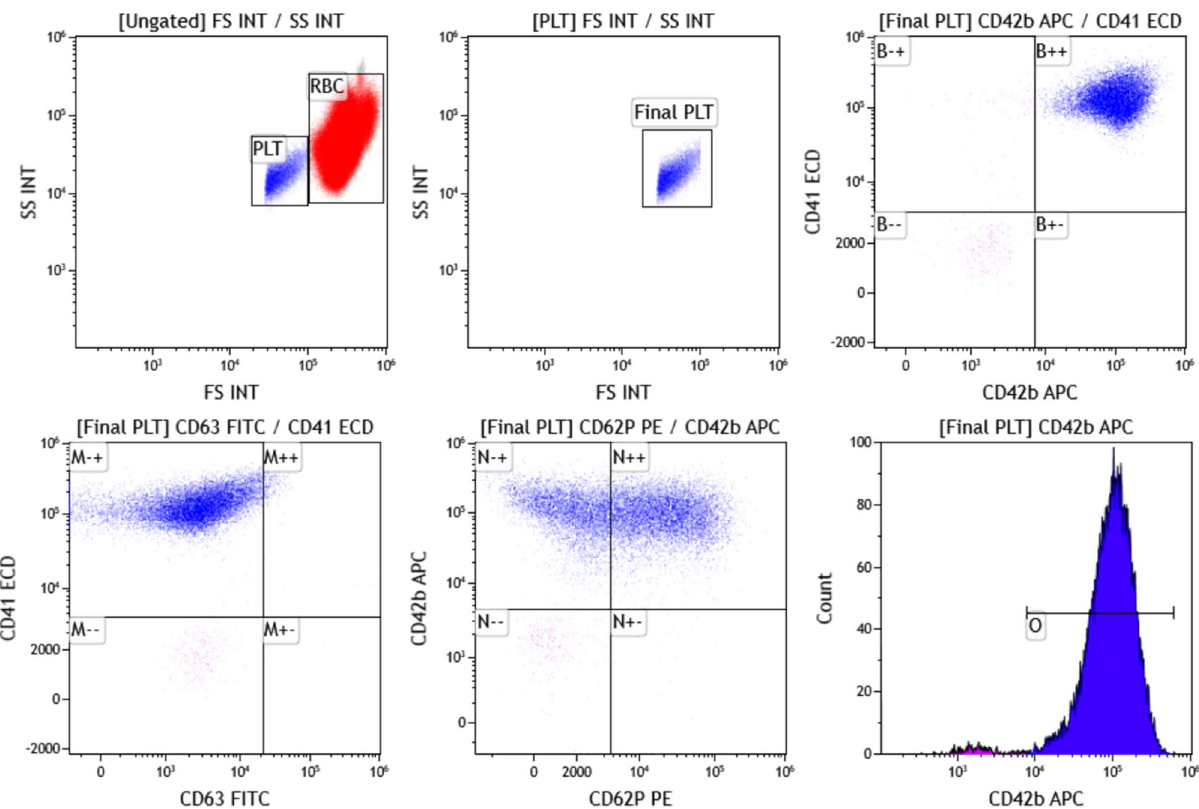
Figure 1. CD62P and CD63 expression on Platelets (PLT), samples were analyzed by flow cytometry, gating by forward/side scatter for